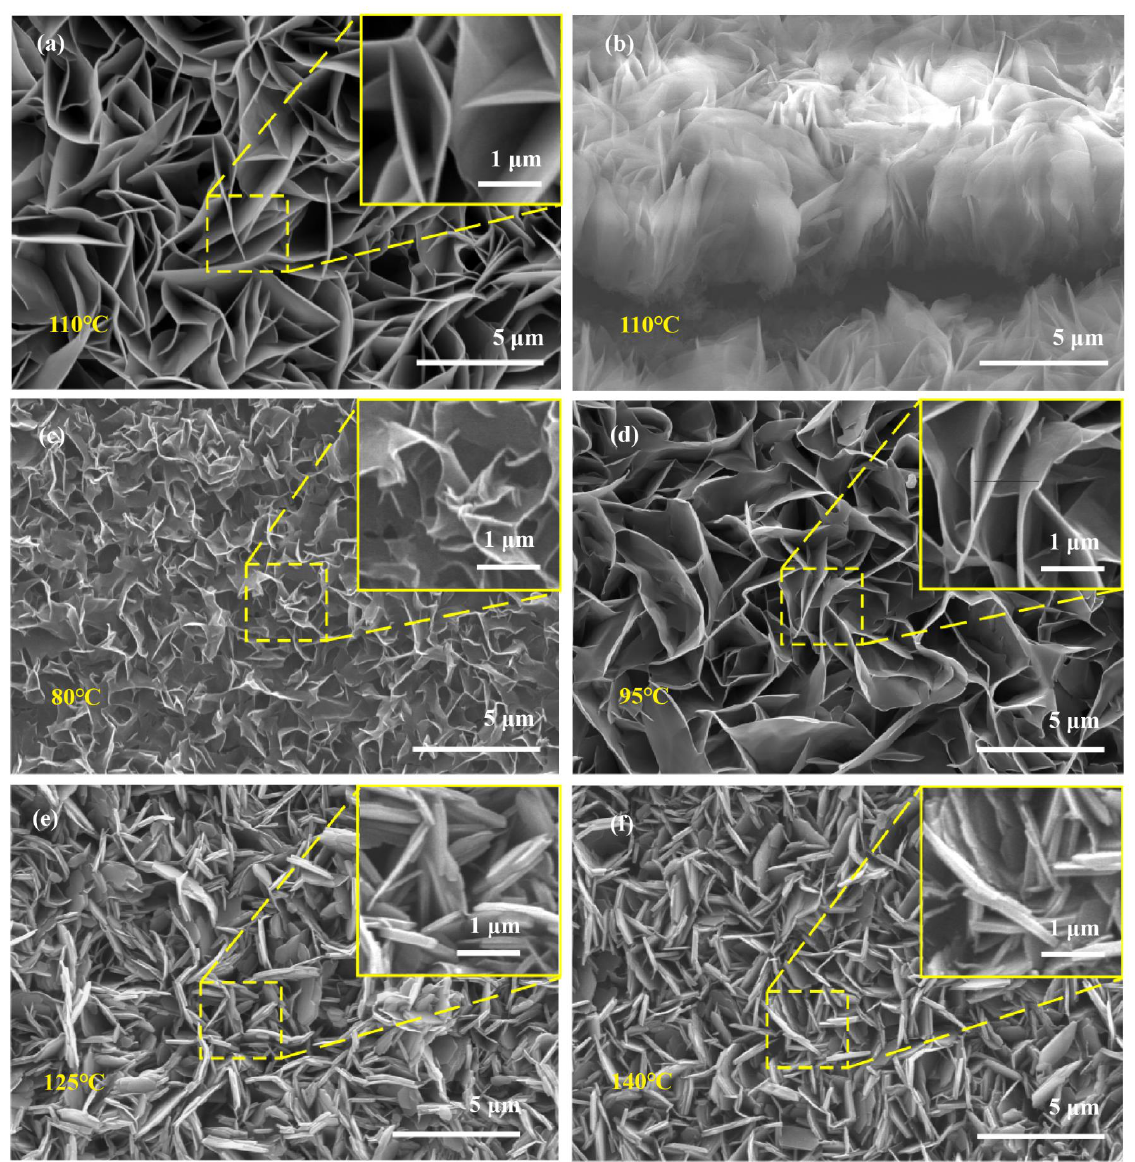
Figure 1. SEM images of supported nanosheet with different hydrothermal temperatures ( a ) Top-view SEM image of nanosheet arrays grown at 110 °C ( b ) Oblique-view SEM image of nanosheet arrays grown at 110 °C ( c ) 80 °C ( d ) 95 °C ( e ) 125 °C, and ( f ) 140 °C . The insets are the high magnification SEM image of the corresponding arrays.